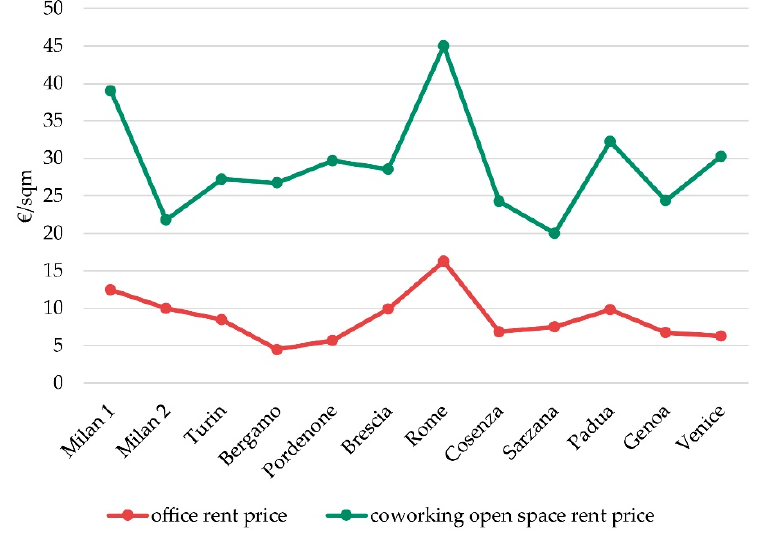
Figure 17. Comparison between average prices per square meter of CSs and traditional offices.